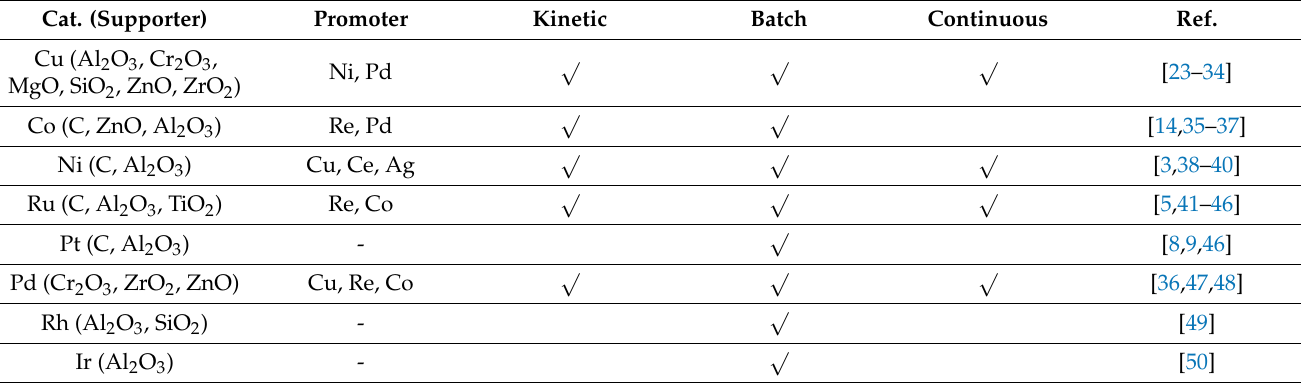
Categories of supported metallic catalysts for glycerol conversion in batch and continuous